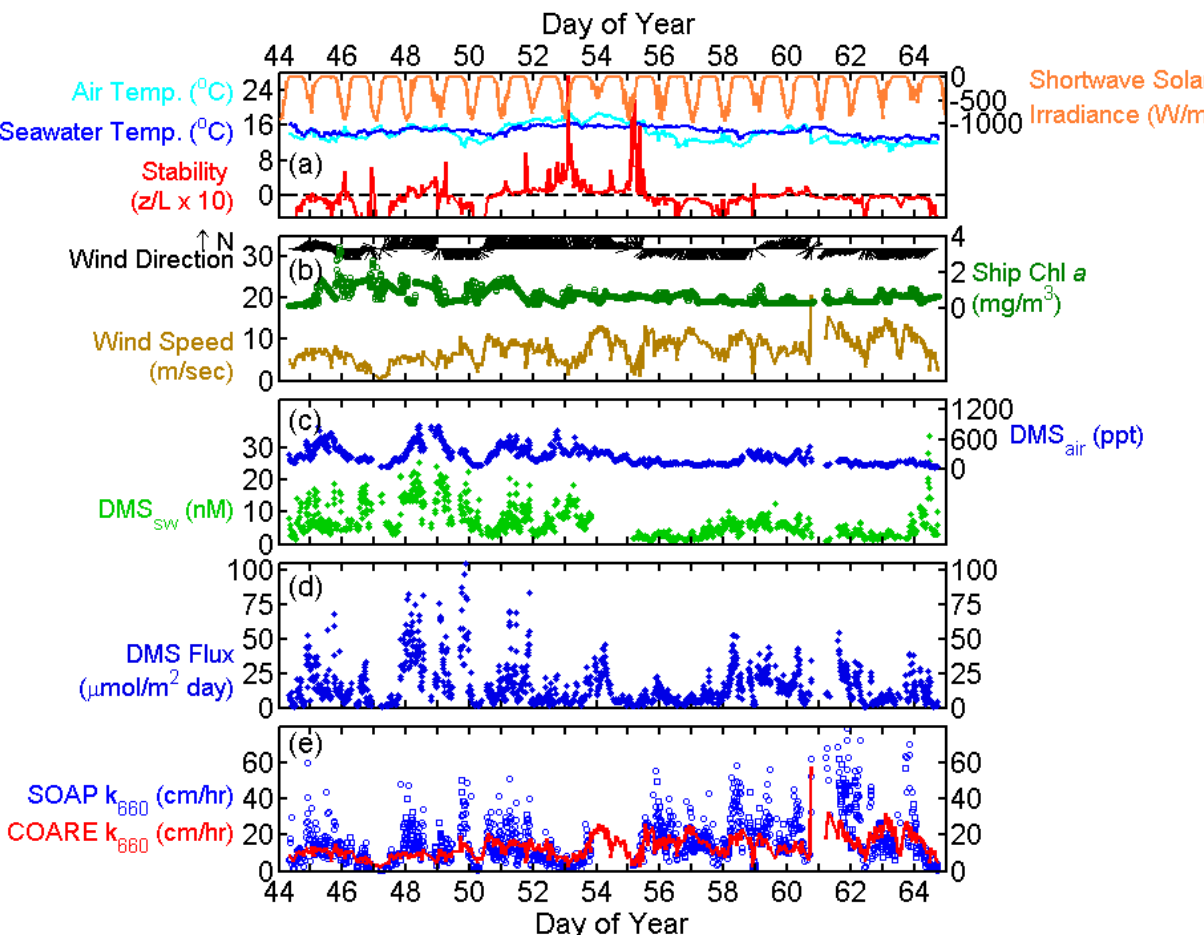
Figure 2. Time series data (10min averages) from the SOAP cruise. The dashed black line in (a) indicates neutral atmospheric stability ( z/L = 0). SOAP k 660 data (e) are divided into on station (squares, ship speed <1.5ms − 1 ) and off station (circles, ship speed ≥ 1.5ms − 1